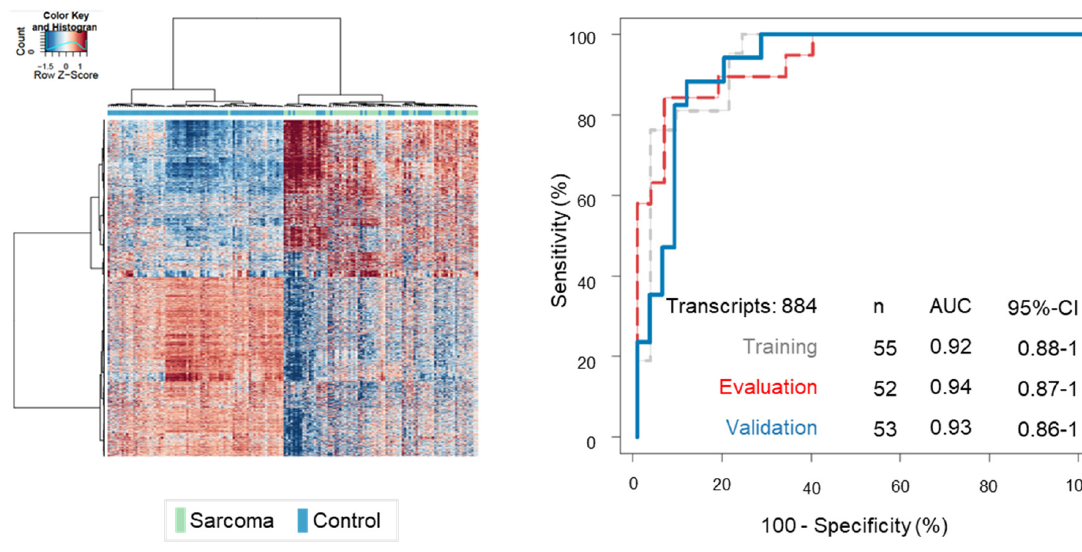
Figure 1. TEP thromboSeq analysis of sarcoma patients versus controls. ( a ) Particle-swarm optimization (PSO) optimized heatmap of sarcoma patients versus controls. Out of 3799 spliced transcripts detected in the blood platelets, 2647 transcripts were di ff erentially expressed spliced junctions (false discovery rate < 0.05) and 2537 transcripts were used for clustering analysis (false discovery rate < 0.033). Unsupervised hierarchical clustering of di ff erentially expressed spliced junction ribonucleic acid (RNA) transcripts between controls (blue, number ( n ) = 103) and sarcoma patients (green, n = 57). The columns indicate the di ff erent patient samples. The rows indicate the di ff erentially expressed spliced junction RNA transcripts. The color intensity represents the Z score-transformed RNA expression value. ( b ) Receiver operating characteristics (ROC) analysis of the PSO-enhanced thromboSeq classifications using controls, including healthy donors and former sarcoma patients, and patients with sarcoma. The red dashed line indicates the ROC of the evaluation series ( n = 52), classified by the self-learning support vector machine (SVM) algorithm developed with 884 transcripts and spliced RNA levels derived from the training series (Table S2). The grey dashed line indicates the post-hoc assessment of the 884 transcripts by leave-one-out-cross-validation (LOOCV) on the training series ( n = 55). The blue line indicates the ROC of the validation series ( n = 53). As an internal control experiment, shu ffl ed class labels ( n = 1000) resulted a median area under the curve (AUC) in the validation series of 0.47 and an interquartile range (IQR) of 0.36. Shu ffl ed samples in training (1000 iterations) resulted in a median AUC in the validation series of 0.92 with an IQR of 0.05.